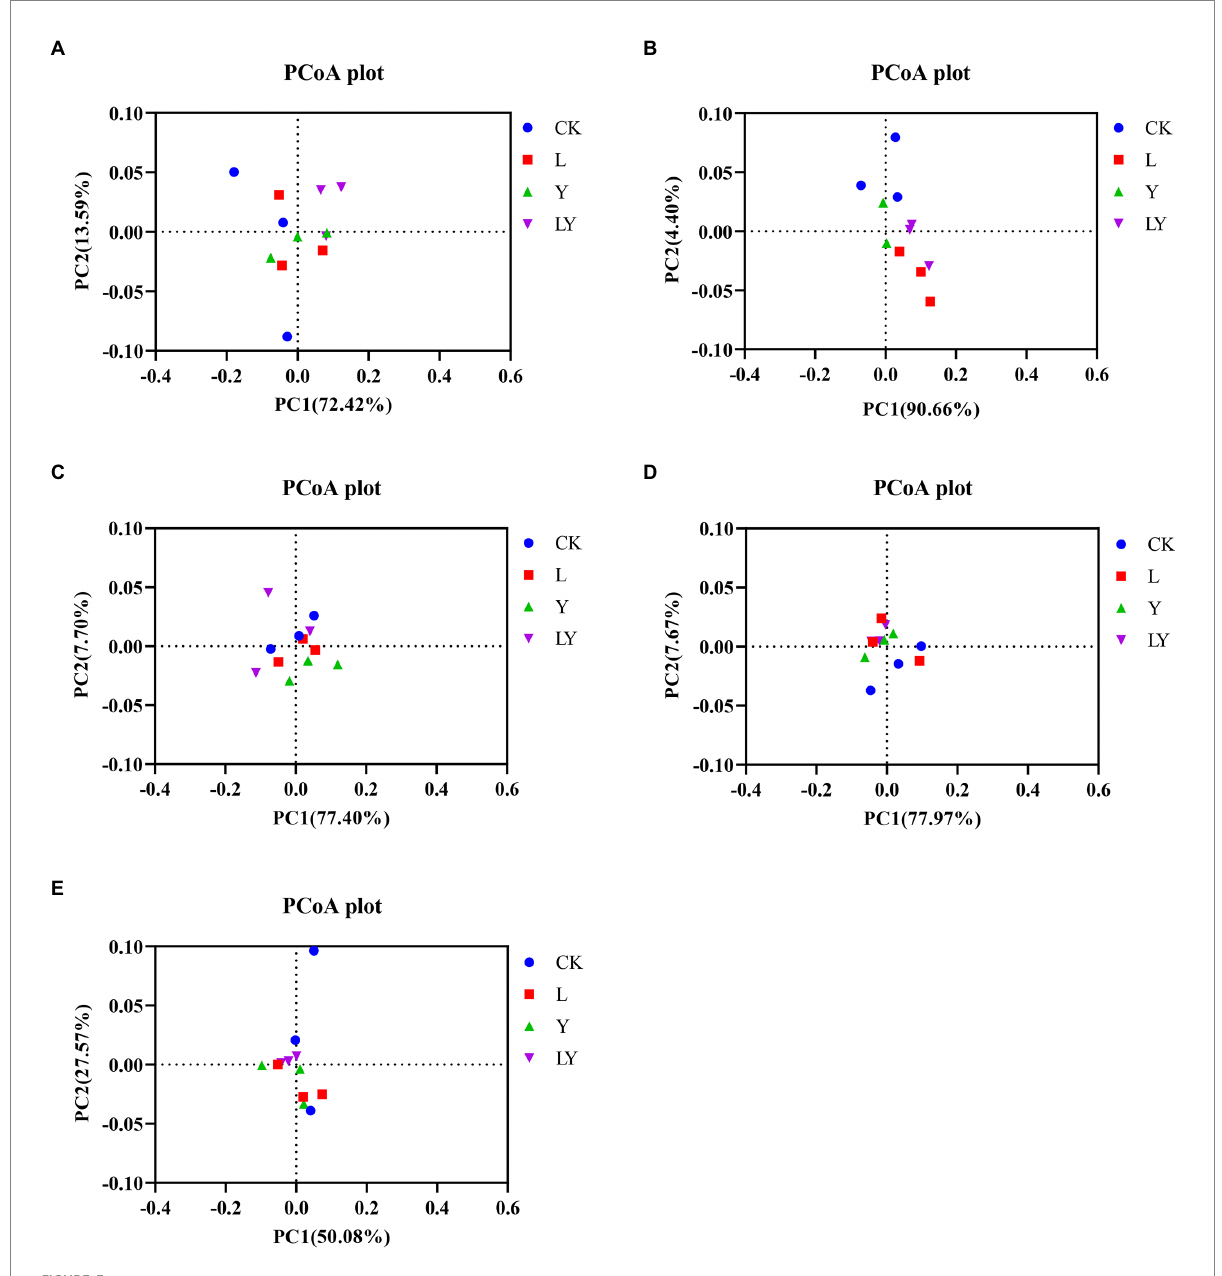
FIGURE. 3 PCoA plot of the bacterial community structure of cellulase-treated Pennisetum sinese (CTPS) after anaerobic storage for 7 days (A) , 14 days (B) , 30 days (C) , 45 days (D) , and 60 days (E) . CK, control; L, Lentilactobacillus buchneri ; Y, yeast; LY, a mixture of L. buchneri and